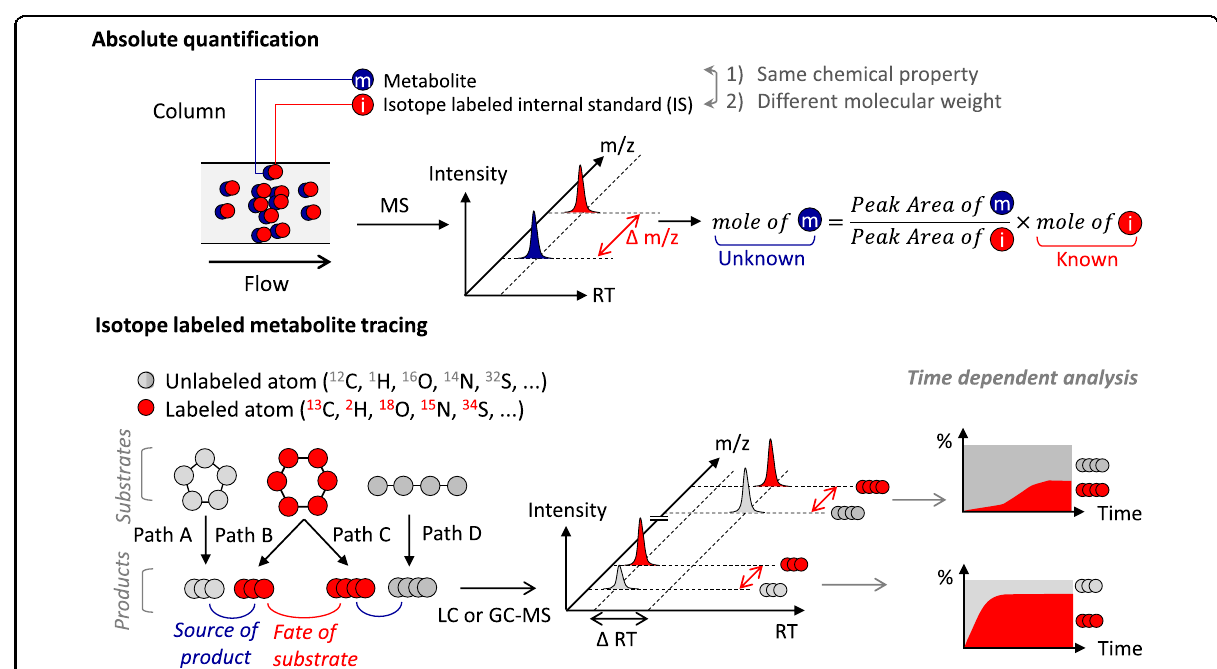
Fig. 2 The use of stable isotopes for absolute quanti fi cation and tracing. (Absolute quanti fi cation) Isotope-labeled metabolite standards can be used as internal standards (IS) to quantify the unknown amount of metabolites in biological samples. Since the IS has the same chemical properties as the target metabolite, variation during sample preparation and instrumental analysis can be corrected. Furthermore, the metabolite and IS can be distinguished during MS analysis due to the difference in their molecular weights. Finally, the quantity of the metabolite can be calculated by determining the peak area ratio of metabolite to IS, and multiplying by the known amount of the IS. (Metabolite tracing) The fate of isotope-labeled metabolite substrates can be traced into downstream products by chromatography coupled to MS. By calculating the isotope enrichment of a target metabolite, the relative contribution of different pathways to that metabolite pool can be evaluated. Furthermore, time-course analysis facilitates the determination of fl ux through metabolic pathways. MS mass spectrometry, m/z mass to charge ratio, LC liquid chromatography, GC